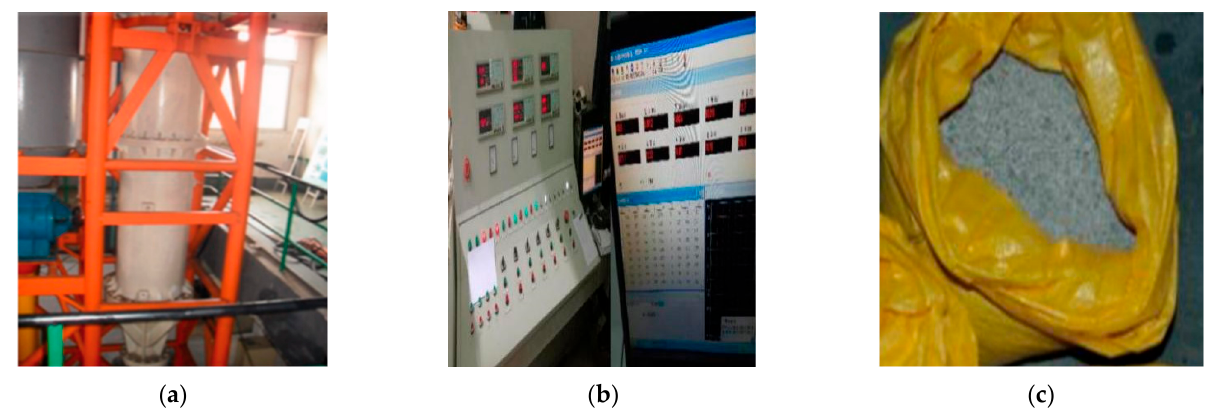
Figure 24. Test site: ( a ) mining pump test bench; ( b ) measurement and control system; ( c ) test